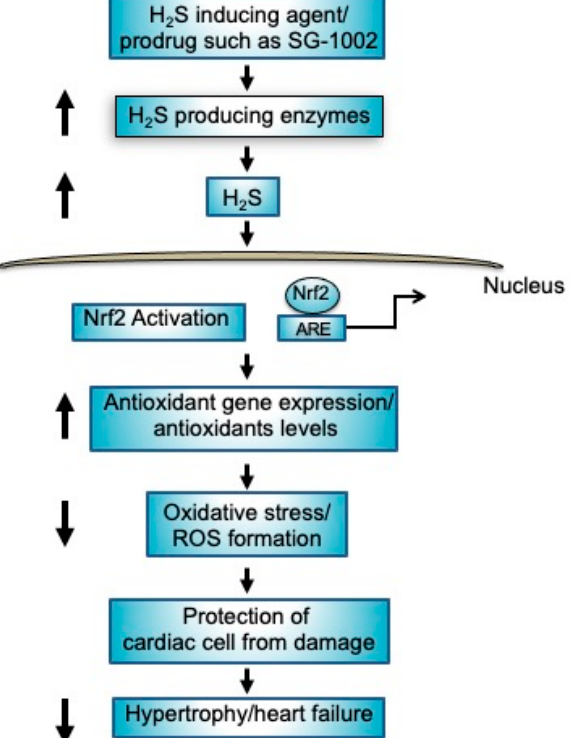
Figure 8. Mechanisms of protection of cardiac cells by H 2 S producing agents such as prodrug SG- 1002. Treatment of SG-1002 induces H 2 S producing enzymes resulting in increased production of H 2 S. Increased levels of H 2 S activates nuclear Nrf2 as well as causing elevation of antioxidant gene expression/antioxidants levels resulting in protection of cardiac cell from damage leading to the inhibition of hypertrophy/HF.